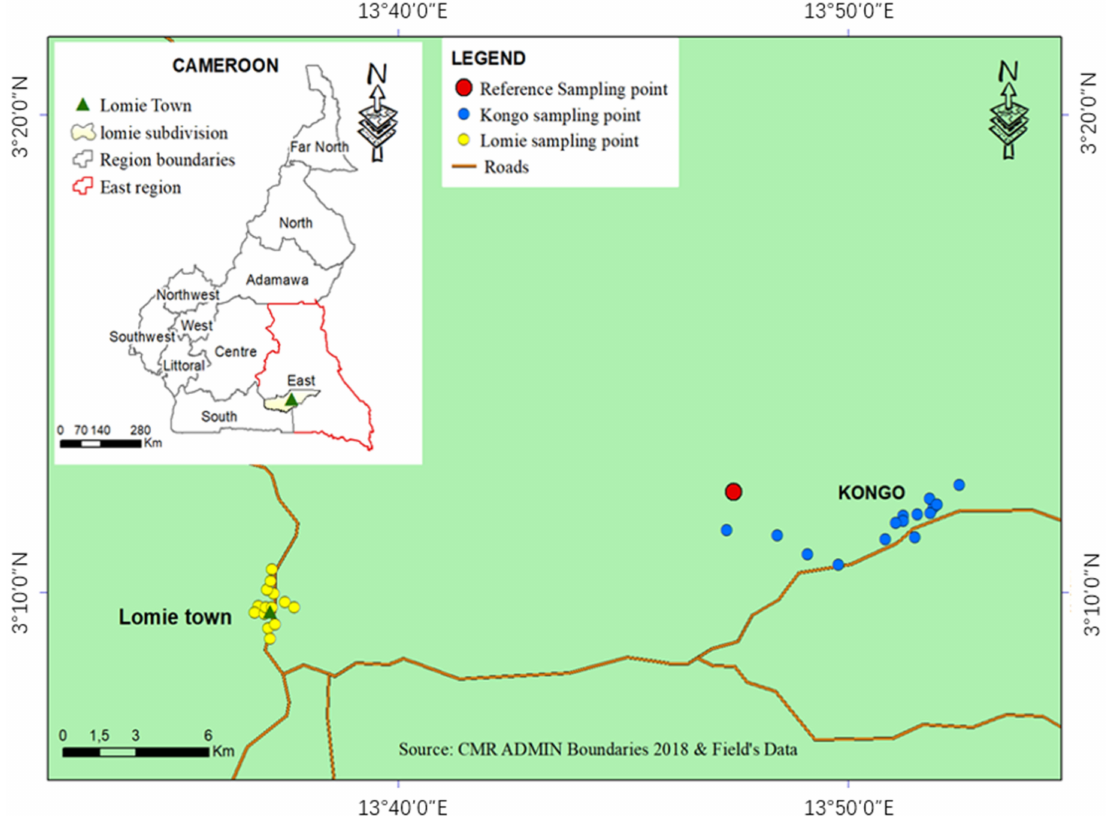
Figure 1. Map of the study area showing the sampling points in Kongo, where the cobalt–nickel deposit is located, and in Lomi é , the most populated locality of the